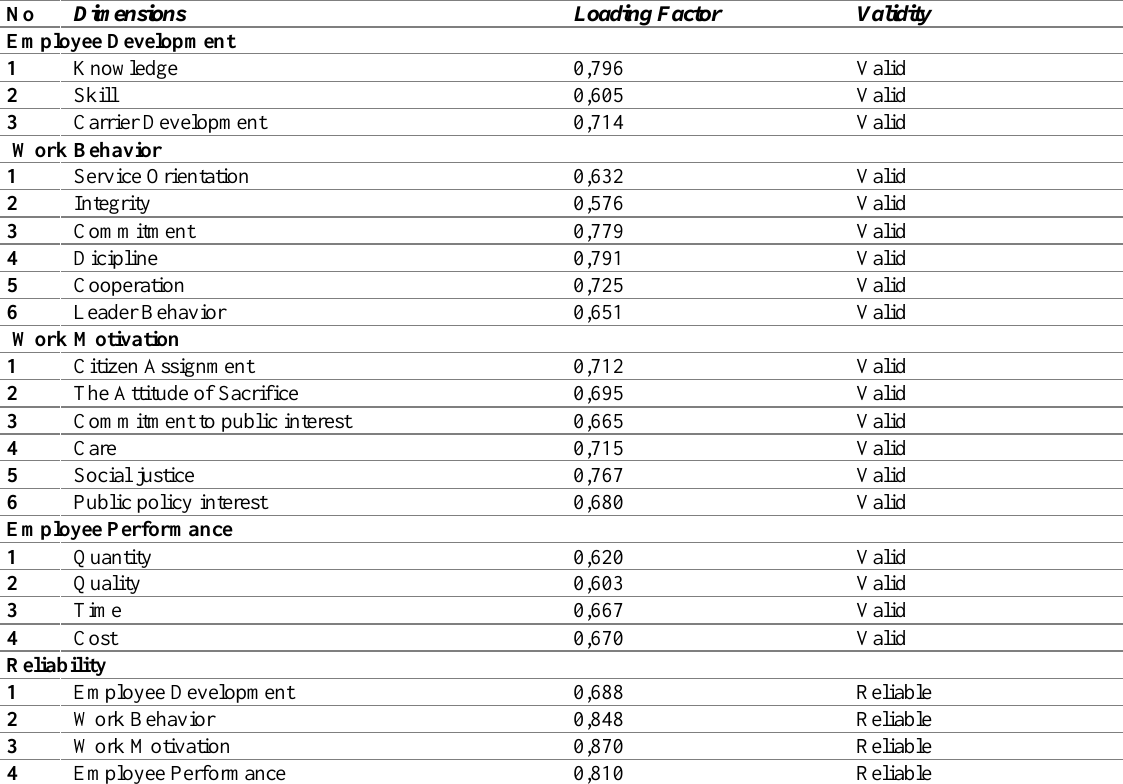
Table 3 : Validity and reliability test